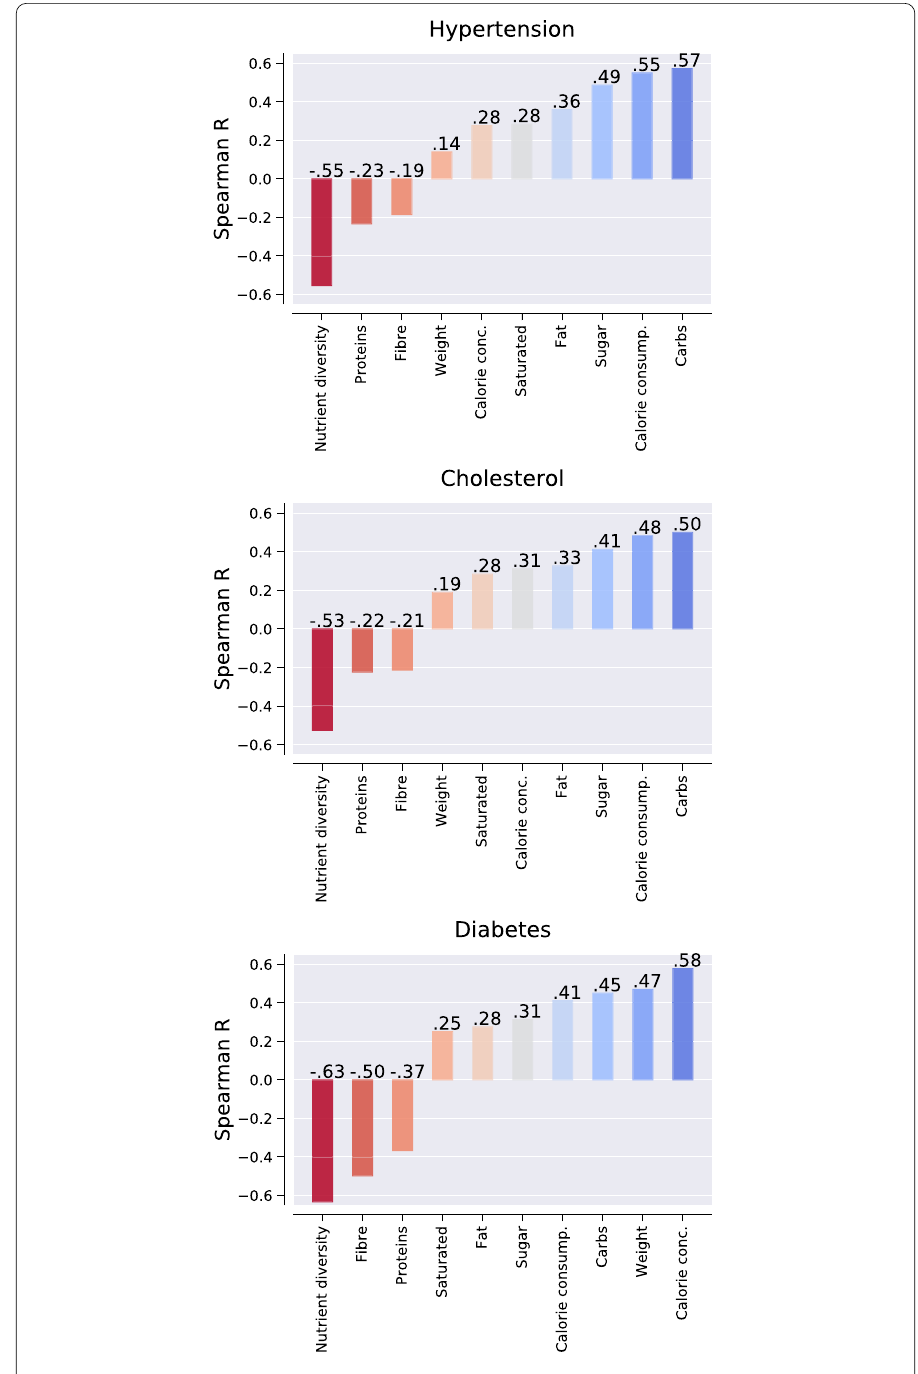
Figure 3 Spearman rank correlations between disease prevalence (as per Formula (1)) and food-related metrics (as per Formulae (2)–(7)). All correlations are significant with p < 0.001